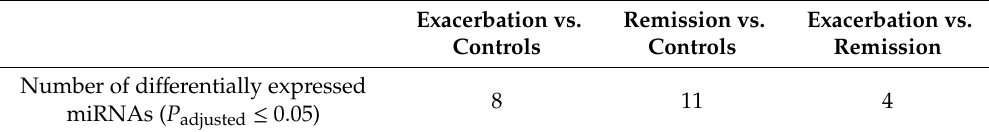
Table 2. Number of statistically significantly di ff erentially expressed miRNAs in all three combinations of the three cohorts studied.